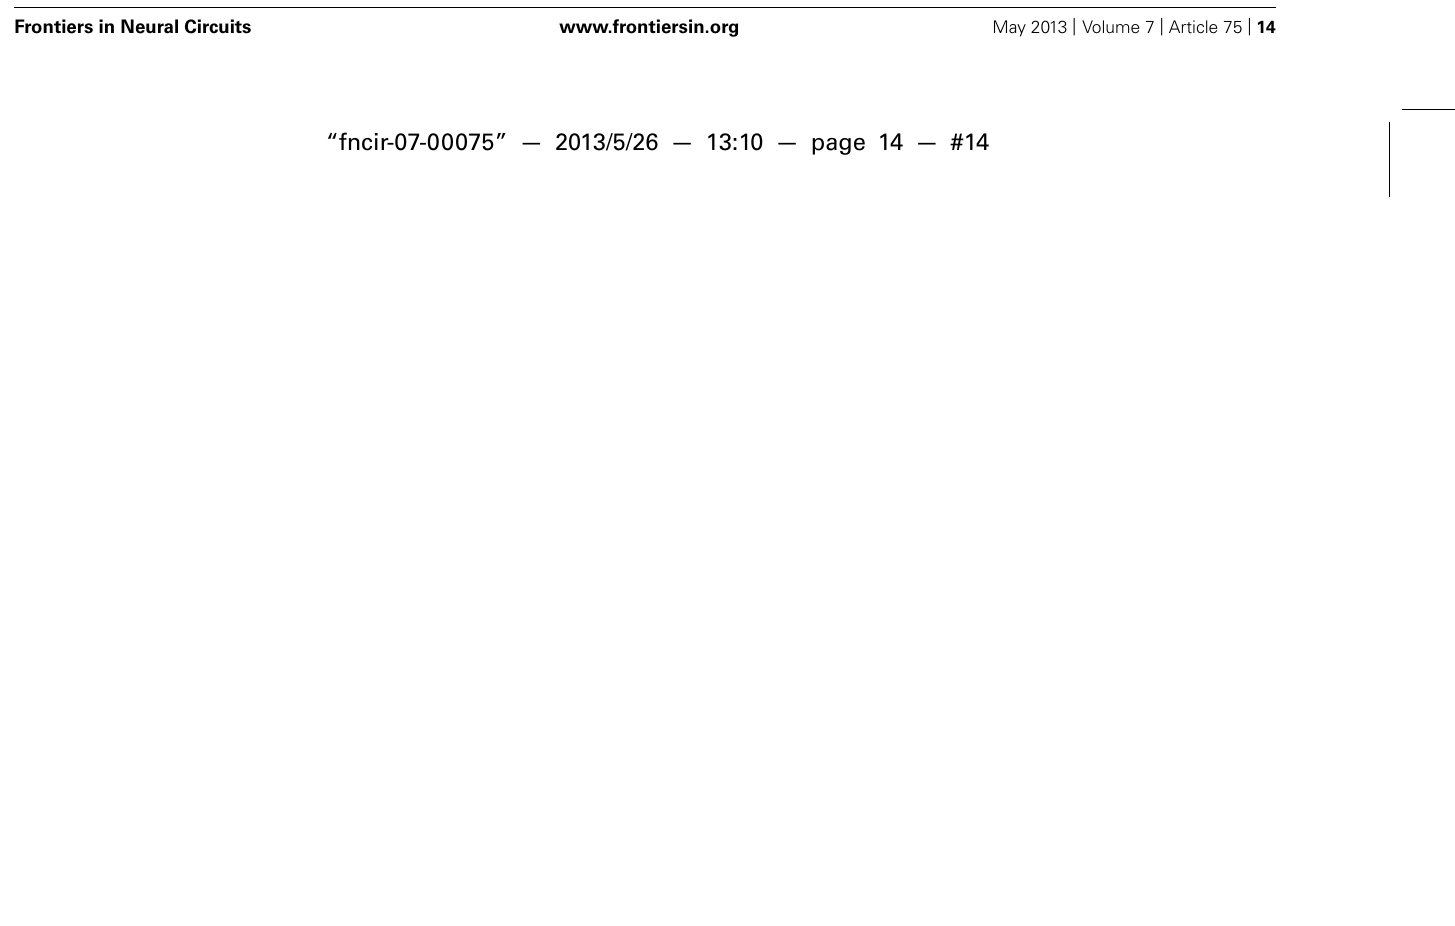
and then send their activity back to the thalamic neurons (red circuit). (B) It is likely that these two circuits are embedded in the cortical microcircuit with relative independence.The blue circuit may behave like a feedforward information-processing system, whereas the red one may serve as a dynamical system because of its recurrent nature. w , subcortical or cortical “driver” afferent vector; x , state vector of thalamic neurons; y , output vector of L2/3 pyramidal neurons; z , output vector of L5 pyramidal